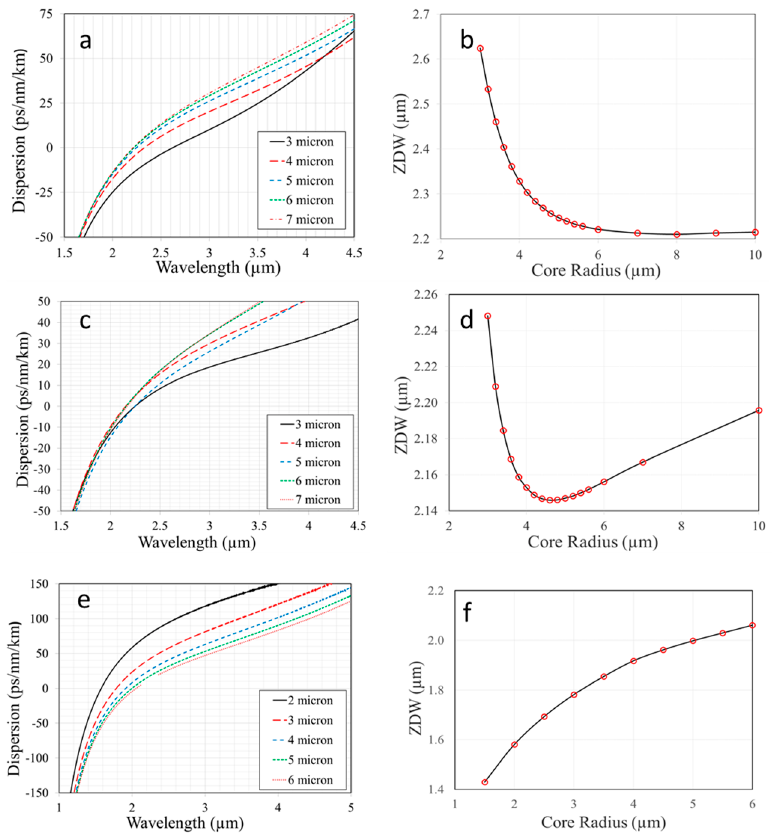
Figure 3. ( a ) Dispersion curve, of the current design (base tellurite core and Er-doped tellurite cladding), relative to wavelength; ( b ) zero-dispersion wavelength (ZDW) relative to core radius for the current design; ( c ) Dispersion curve of the design with base tellurite core and La-doped tellurite cladding, relative to wavelength; ( d ) ZDW relative to core radius for the La-cladding design; ( e ) Dispersion curve of the design with base tellurite core and air-clad design, relative to wavelength; ( f ) ZDW relative to core radius for the air-clad design (all legend refers to radius).